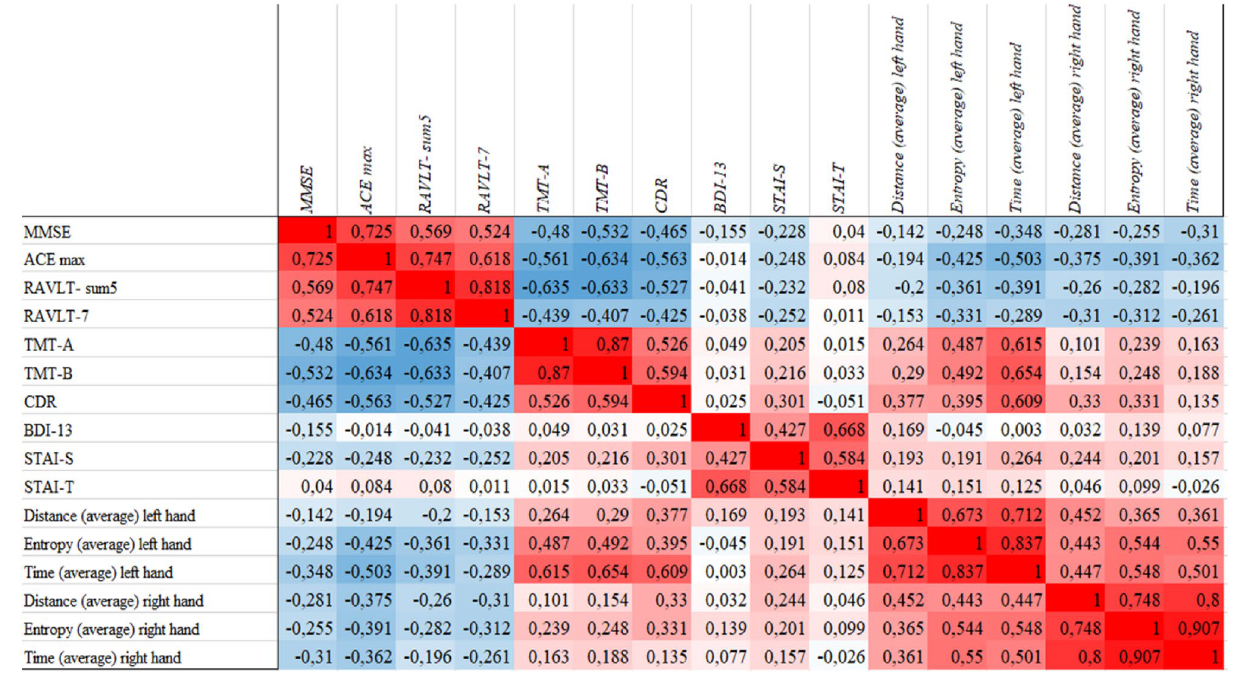
Figure 2. Corrgram between hand movement parameters and neuropsychological test results. Blue color indicates negative correlations, while red demonstrates positive correlations. A clear trend is visible, patients with lower cognitive scores in MMSE, ACE, RAVLT have higher movement values (negative r). However, lower cognitive scores are also indicated with higher TMT and CDR scores, where mouse movements show also higher values (positive r). In conclusion, increase in motor parameters indicates worse cognitive performance. Highest r values are presented in time of left-hand movements. A trend is also visible for higher r values of other movement parameters in case of the left hand. MMSE Mini-Mental State Examination, ACE Addenbrooke Cognitive Examination, RAVLT Rey Auditory Verbal Learning Test, TMT Trail-Making Test, CDR